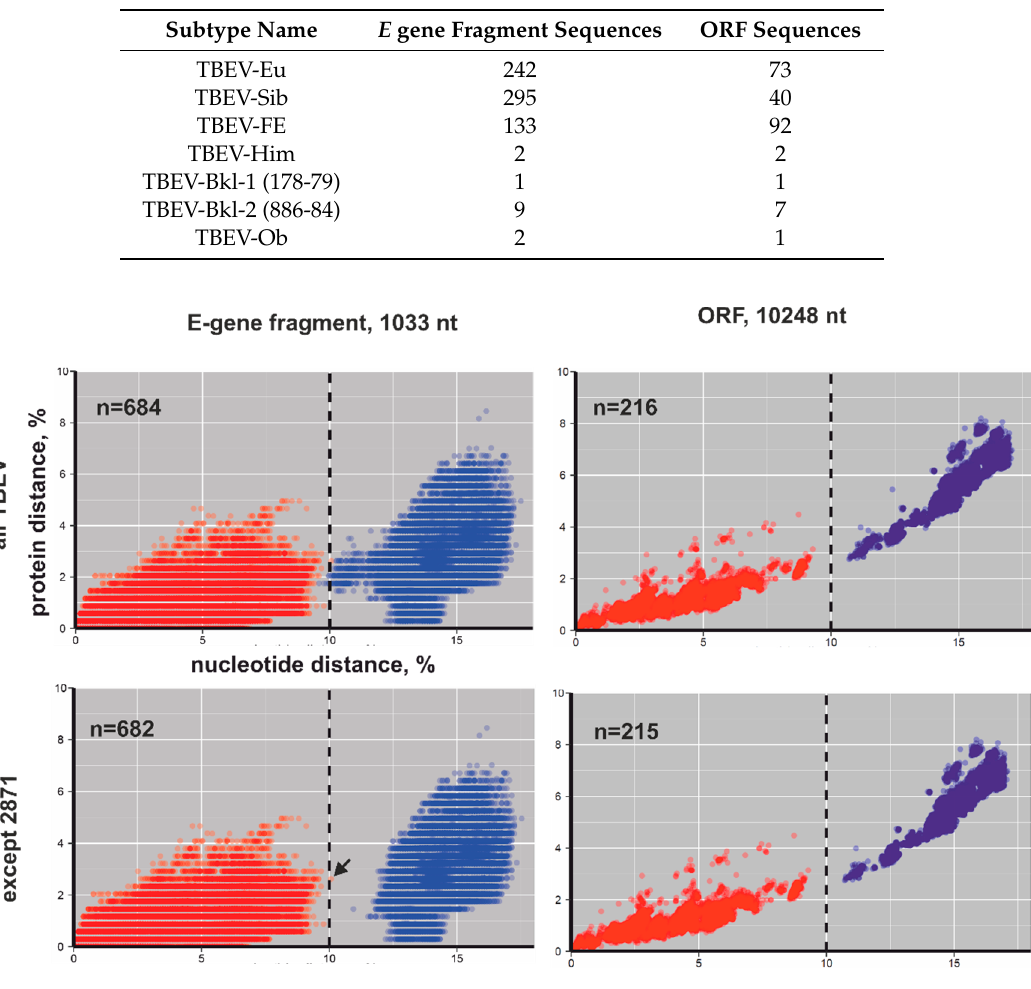
Figure 3. Concordance between nucleotide and amino-acid pairwise distances for TBEV sequences in E gene fragment (left panel) and ORF (right panel). First panel: all TBEV sequences. Second panel: all TBEV sequences except “2871” group viruses. Axes show uncorrected amino-acid and nucleotide sequence distances; dots correspond to distances between each possible pair of sequences in the dataset. The dotted line at 10% nucleotide difference indicates the proposed threshold for segregation of TBEV species into subtypes. Virus pairs were divided into intrasubtype pairs (viruses from the same subtype, indicated by the red color) and intersubtype pairs (viruses from different subtypes, indicated by the blue color).